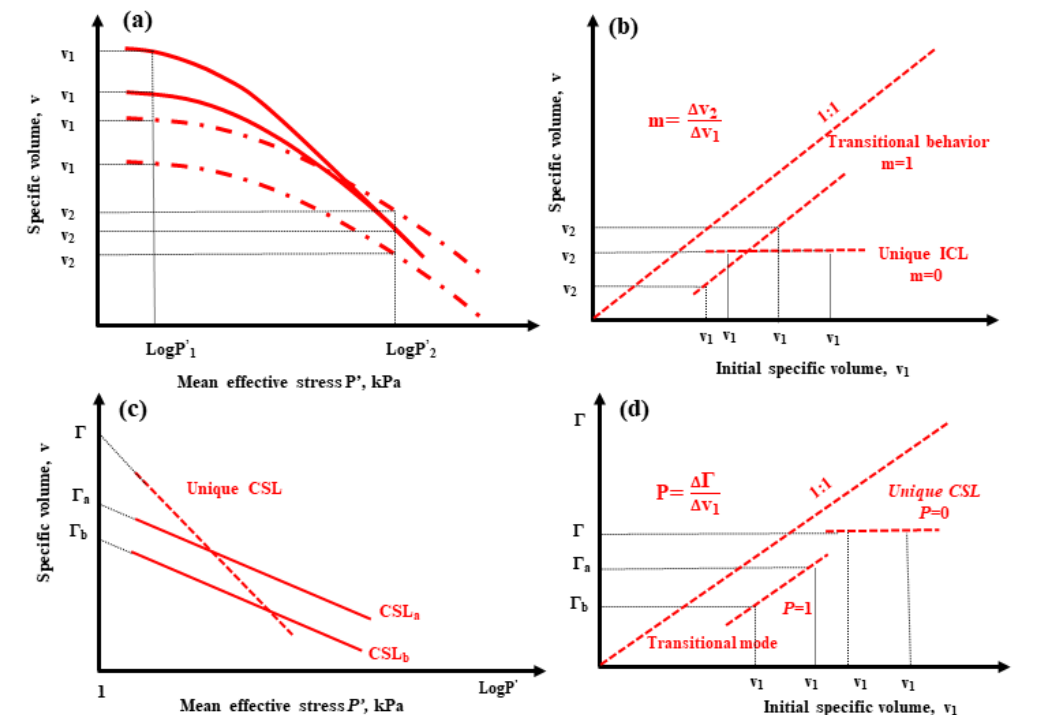
Figure 1. Calculation of m and P parameters; ( a ) compression lines, ( b ) quantifying the m parameter, ( c ) critical state lines, ( d ) quantifying the P parameter [12].